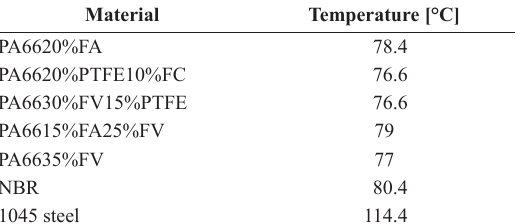
Table 3. Average temperatures reached during the wear test.